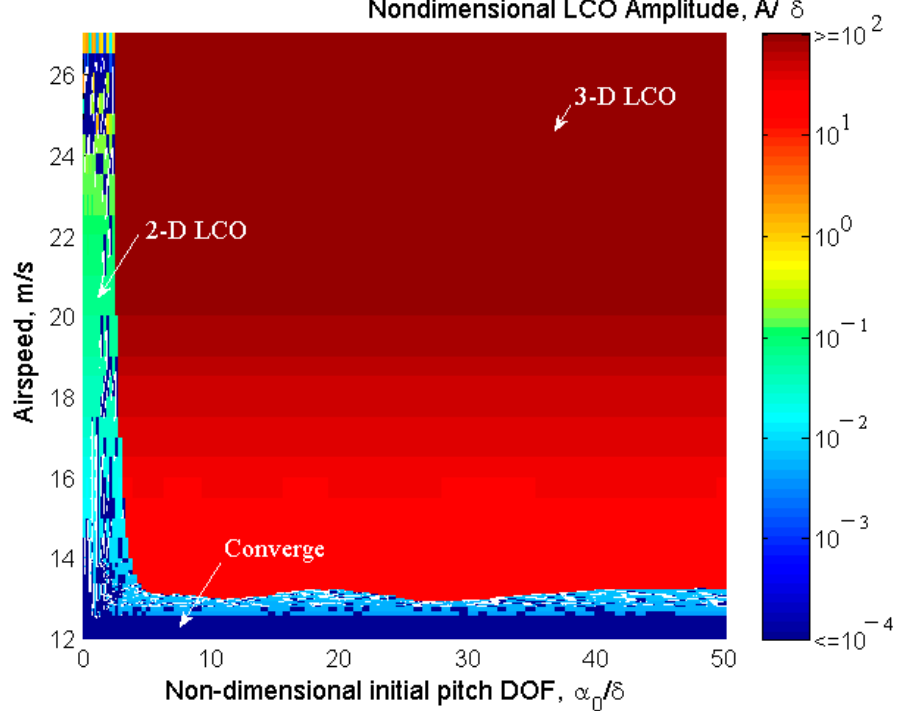
Figure 16. System behaviors derived from the 7300 cases, where a 3-D LCO region with a clear boundary and a 2-D LCO region mingled with the converging region are found.